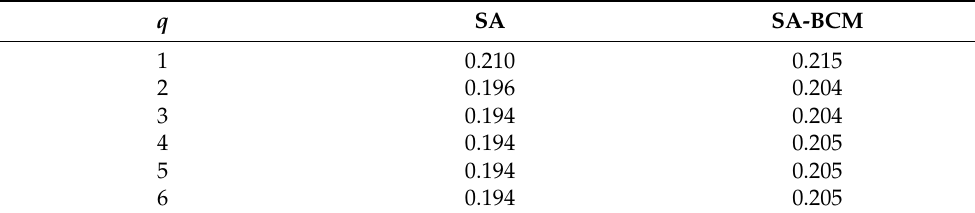
Table 2. Steady case. Space convergence shown by means of the trend of the drag coefficient C D at increasing polynomial degree q